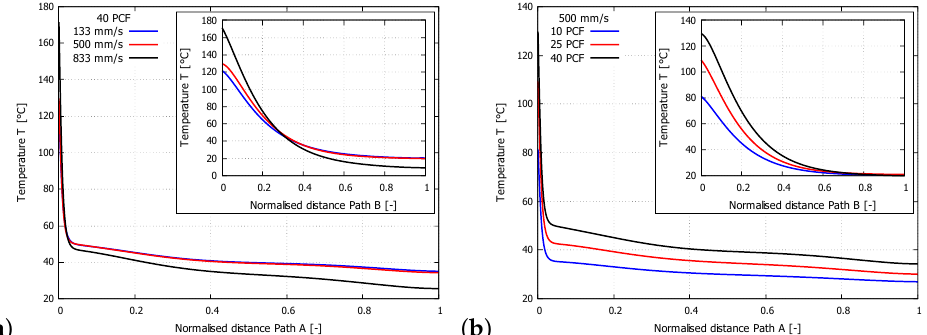
Figure 7. ( a ) Graph of the magnitude of the temperatures on Paths A and B for a constant density (40 PCF) with different cutting speeds. ( b ) Graph of the magnitude of the temperatures on Paths A and B for a constant cutting speed (500 mm/s) with different sample